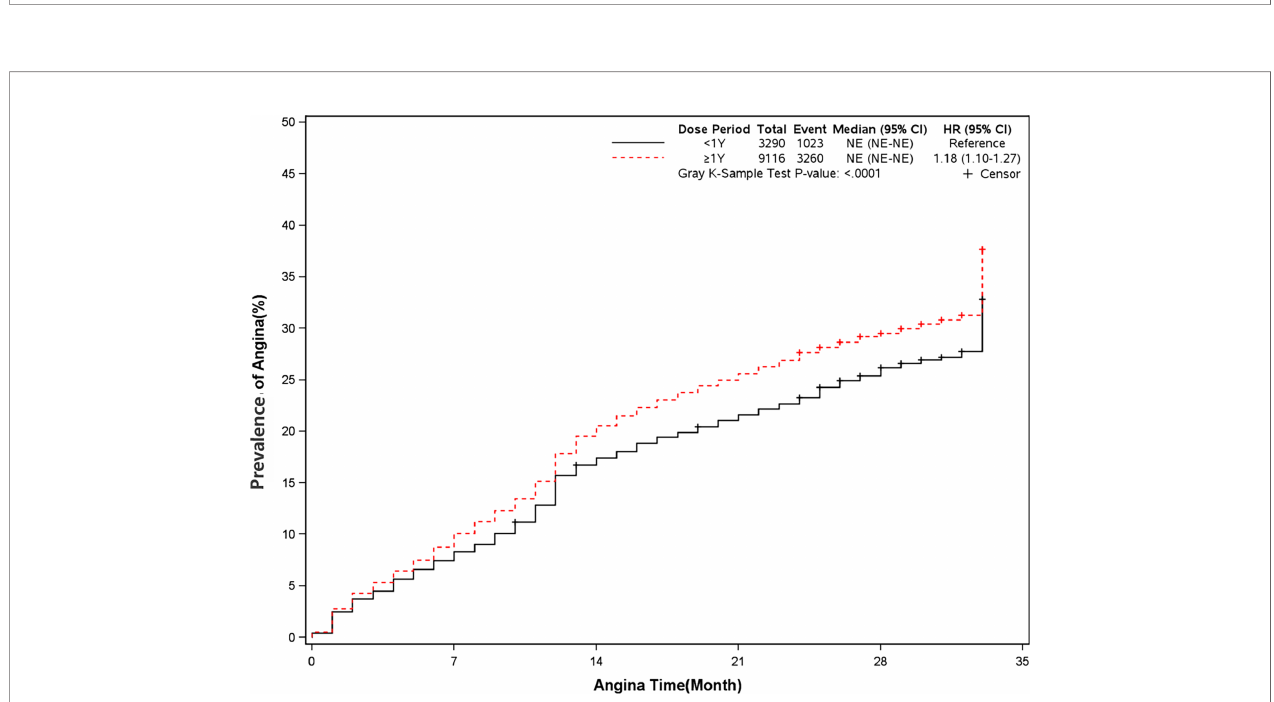
FIGURE 7 | Prevalence of angina in two groups. Blackline: patients took clopidogrel continuously < 1 year; Red line: patients took clopidogrel continuously ≥ 1 year.